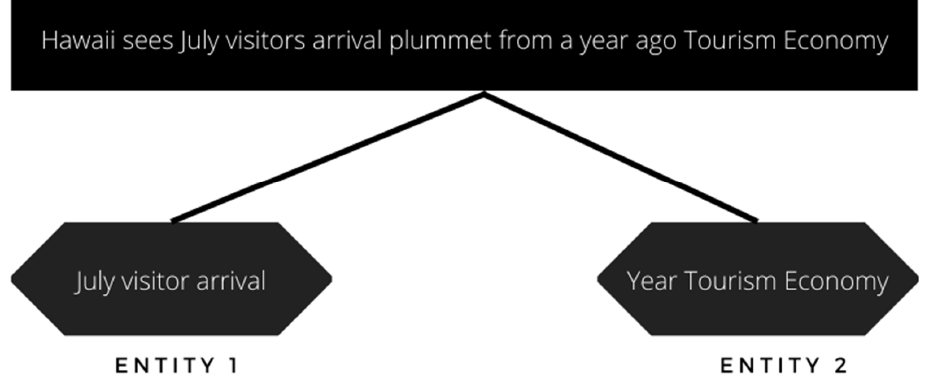
Figure 11. Entity Pair Extraction.